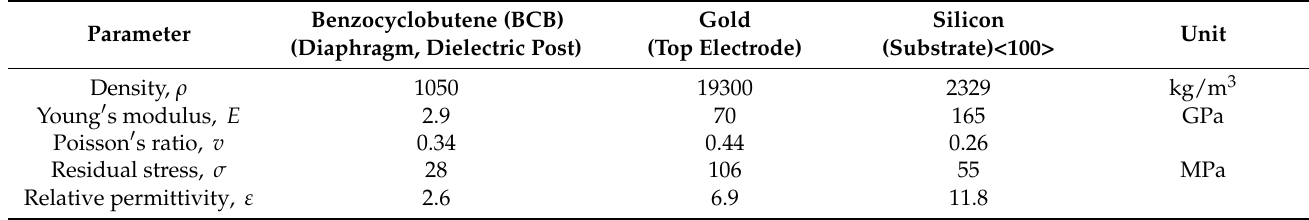
Table 2. CMUT array material physical properties [21].